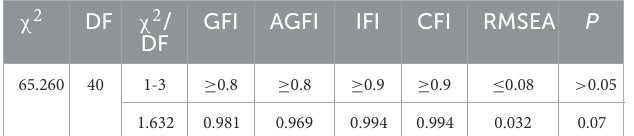
TABLE 3 Fitting indexes of the